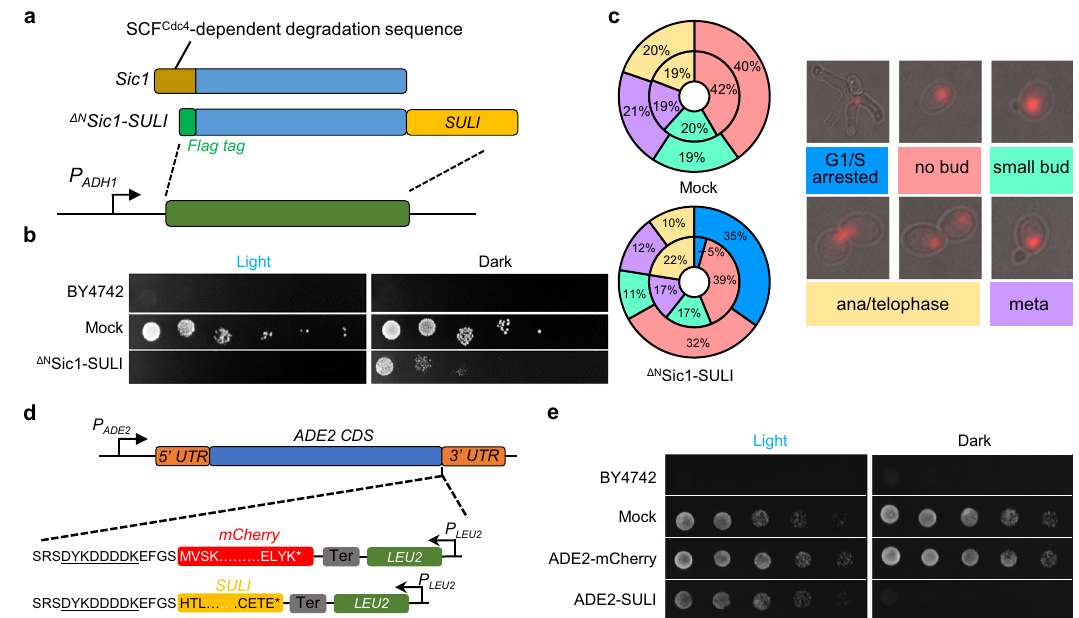
Fig. 5 | Optical control of the cell cycle and growth. a Schematic representation oftheSULI-controlledstabilityof Δ N Sic1.SULIwasfusedtotheC-terminusof Δ N Sic1, whose SCF Cdc4 -dependent degradation sequence (amino acids 1 – 105 of Sic1) was deleted. b Yeast cells expressing Δ N Sic1-SULI were serially diluted (1:10; fi rst spot, ~2.5×10 4 cells) and grown in solid medium under light or dark conditions. BY4742 cells transformed with empty vectors were used as the controls. c The same yeast cells as in b were cultured under light or dark conditions for 10h before imaging. The circular graphs (inner ring, dark conditions; outer ring, light conditions) show themeandistributionofcellcyclestagesobtainedfromthreebiologicalreplicates.